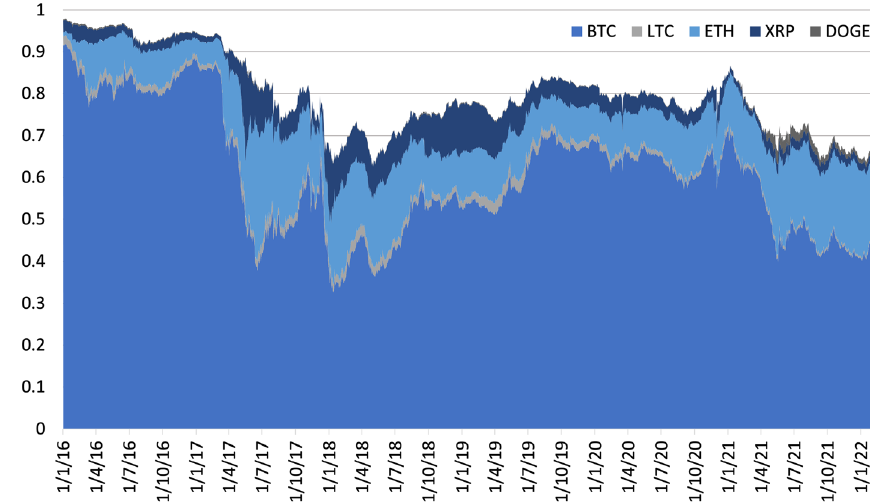
Fig. 2 Combined market capitalization of BTC, LTC, ETH, XRP, and DOGE. Note: Depicted in relation to the total cryptocurrency market capitalization between January 1, 2016, and January 31, 2022. Data are retrieved from coinm arket cap.